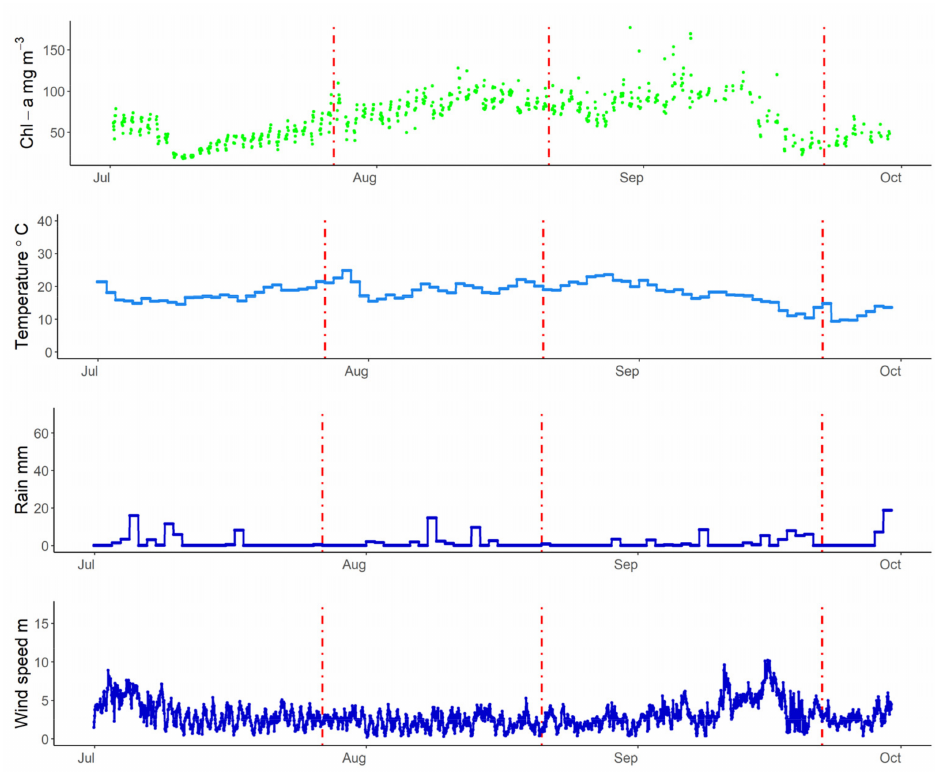
Figure 9. Curonian Lagoon Chl-a (hourly), air temperature (hourly), rain (daily total), and wind speed (hourly) between July and September 2019. Dashed red lines indicate 27 July, 21 August, and 22 September